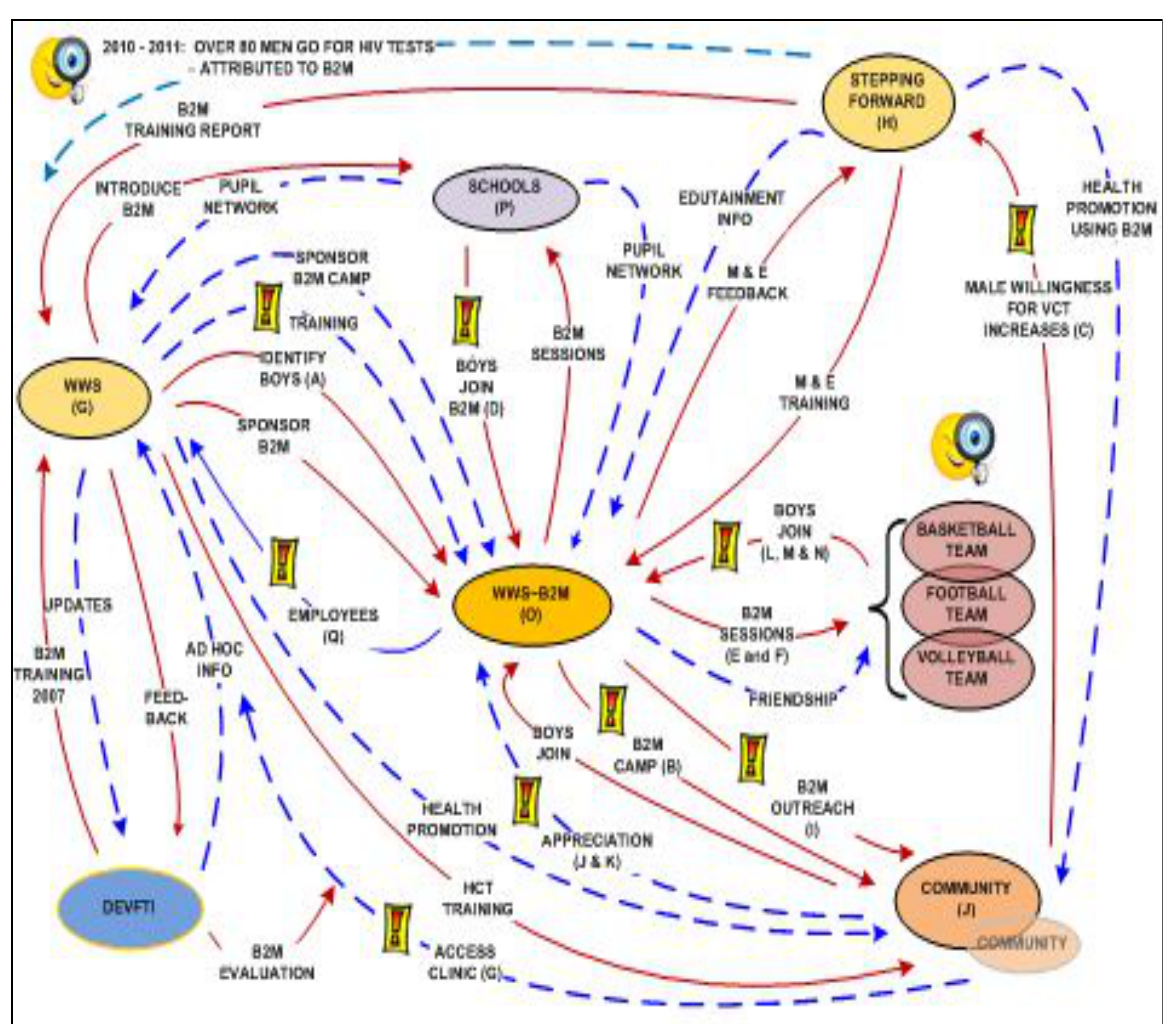
Figure. 4. The overall network with the formal interactions represented by solid lines and the informal interactions represented by dotted lines. Source : authors' contribution